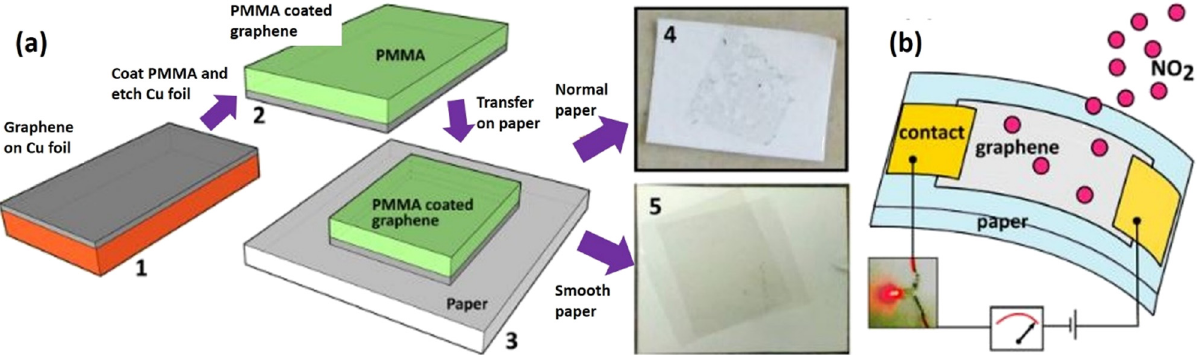
Figure 10: ( a ) and ( b ) Schematic diagram of graphene transfer process on to the paper. Starting with ( 1 ) graphene on Cu foil, ( 2 ) a layer of poly ( methyl methacrylate ) ( PMMA ) is spin - coated and Cu is etched to get graphene supported by PMMA in water, ( 3 ) PMMA - graphene fi lm is then dredged on to paper and PMMA is dissolved with acetone and ( 4 ) normal paper yields patchy coverage compared to transfer on smooth paper ( 5 ) . The smooth paper at ( 5 ) shows two layers of graphene transferred on smooth paper. ( b ) Schematic of a G - paper strip in action as a gas sensor. The circuit had su ffi cient current to make an LED glow (( bottom left ) . Reproduced from ref. [ 106 ]